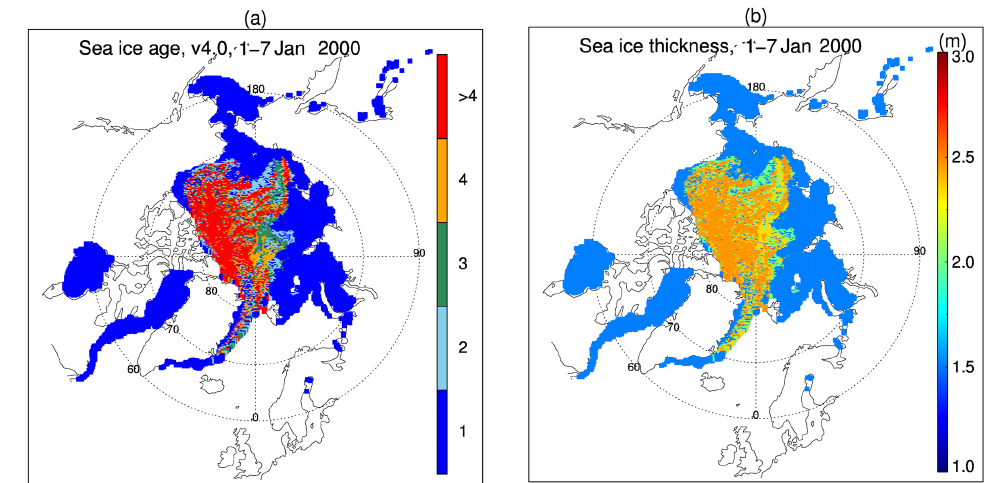
Figure 4. Ice age and ice thickness derived from ice age (1–7 January 2000). Table 1. Statistics of the comparison of ice thickness from the IceAgeDerived product, PIOMAS, and OTIM to submarine upward-looking sonar (1984–2000), ICESat (2004–2008), and CryoSat-2 (2011–2018) in February–March (top row), and October–November (bottom row) over the SCICEX data release area. Correlation squared with a higher than 95% confidence level is in